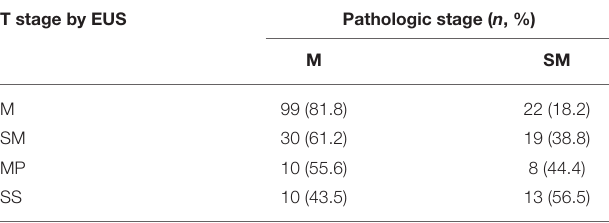
TABLE 2 | Accuracy rates for T staging by endoscopic ultrasonography ( n = 211). T stage by